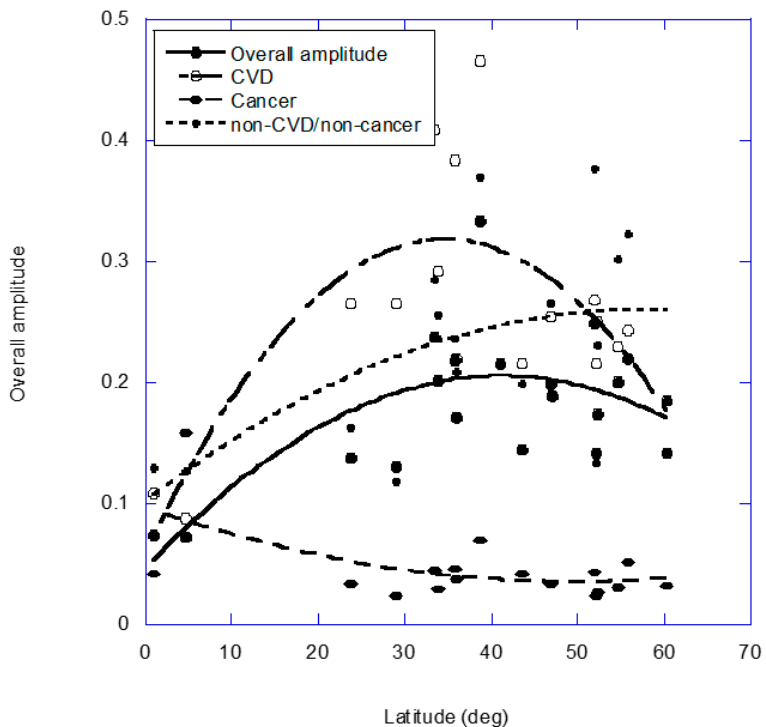
Figure 1. Plot of overall cardiovascular disease (CVD), cancer and non-CVD/non-cancer deaths showing seasonal variations versus ‘absolute’ latitude for 19 countries from Marti-Soler and colleagues [1]. The regression fits are second-order.